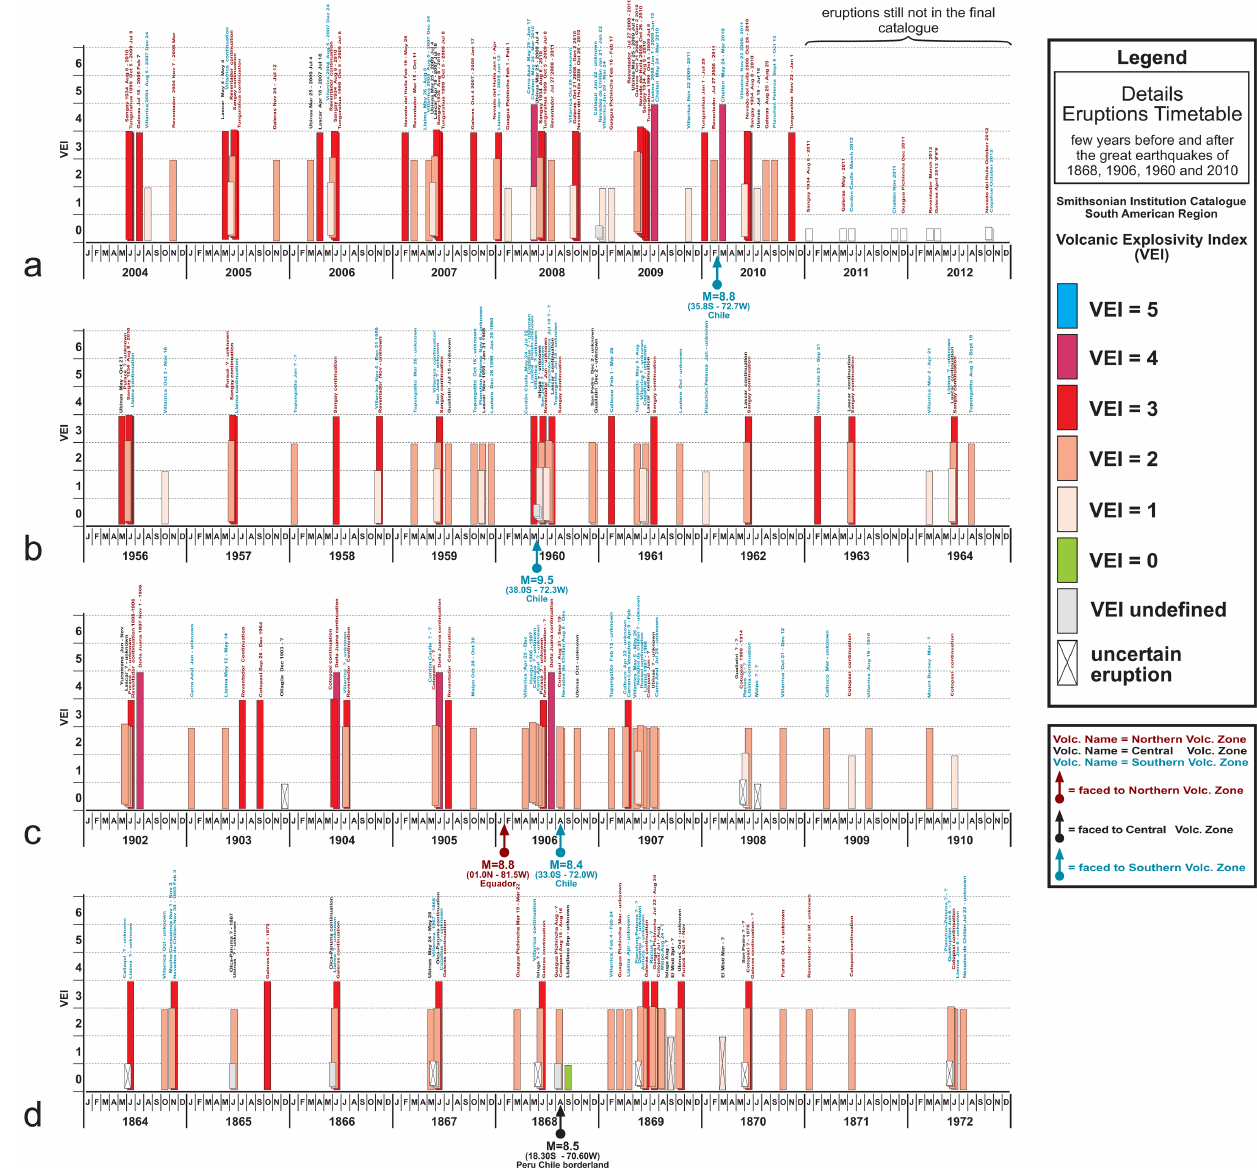
Fig. 3. Details of the eruptions that occurred few years before and after the major South American earthquakes. The VEI is represented both in colour and in length on the vertical axis. The details of the eruptions are shown for the 1868, 1906, 1960 and 2010 seismic events. The eruptions are identified by the name of the volcano and – if available – the starting and ending dates. The colour of the name is assigned as in Fig. 1. If, in the Smithsonian Institution Catalogue, the month of the starting date is not available, the bar representing the eruption is assigned arbitrarily to June or July of the same year. The occurrence of a greater rate of eruptions on the occasion of major earthquakes is observable in this plot, and a trend toward a precursory occurrence of a higher eruption rate is discernible passing from the oldest (1868) to the most recent (2010) correlation event. This can be seen with stronger evidence in the following Fig. 4. The trend may be due to errors in assigning the years of the eruptions when modern technical facilities were lacking (see the discussion in the text). Although this trend was consolidated by the 2010 volcano-seismic event, a longer time lapse for collecting data is needed for more solidly grounded